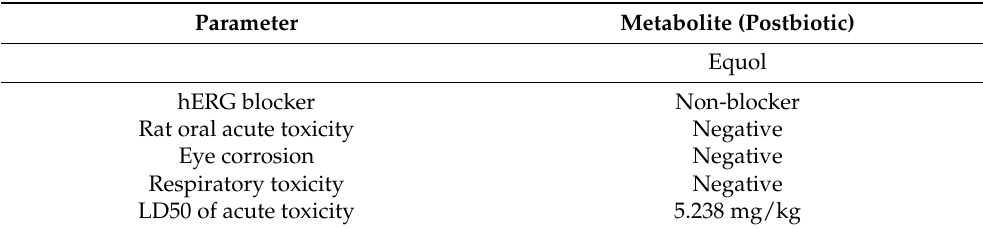
Table 6. Toxicity profile of